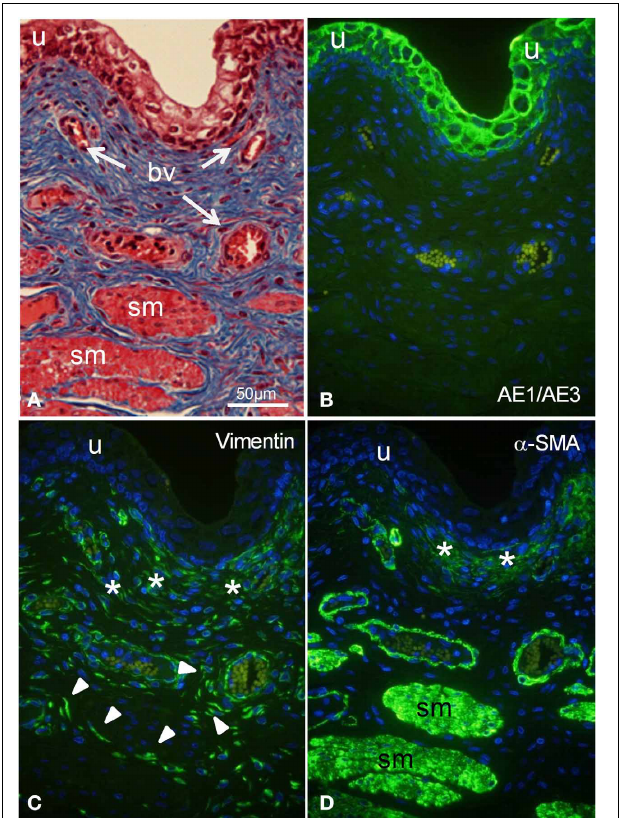
FIGURE 1 | (A) Histological staining (A) and fluorescent immunostaining (B–D) of intact segments of porcine bladder. (A) Masson’s staining showing urothelium (u), smooth muscle bundles (sm), and blood vessels (bv). (B) Immunocytochemical characterization with AE1/AE3 (cytokeratin marker) shows staining of urothelium only. (C) Immunostaining with vimentin shows labeling of large spindle-shaped cells (arrowheads) and a cell layer ( ∗ ) under the urothelium. (D) Immunostaining with α -SMA (smooth muscle marker) shows labeling of smooth muscle bundles, the outer perimeter of blood vessels as well as part of a cell layer ( ∗ , suburothelium) under the urothelium. All cells were double stained with DAPI (cell nuclei, blue). All panels are shown at the same magnification. Bar = 50 μ